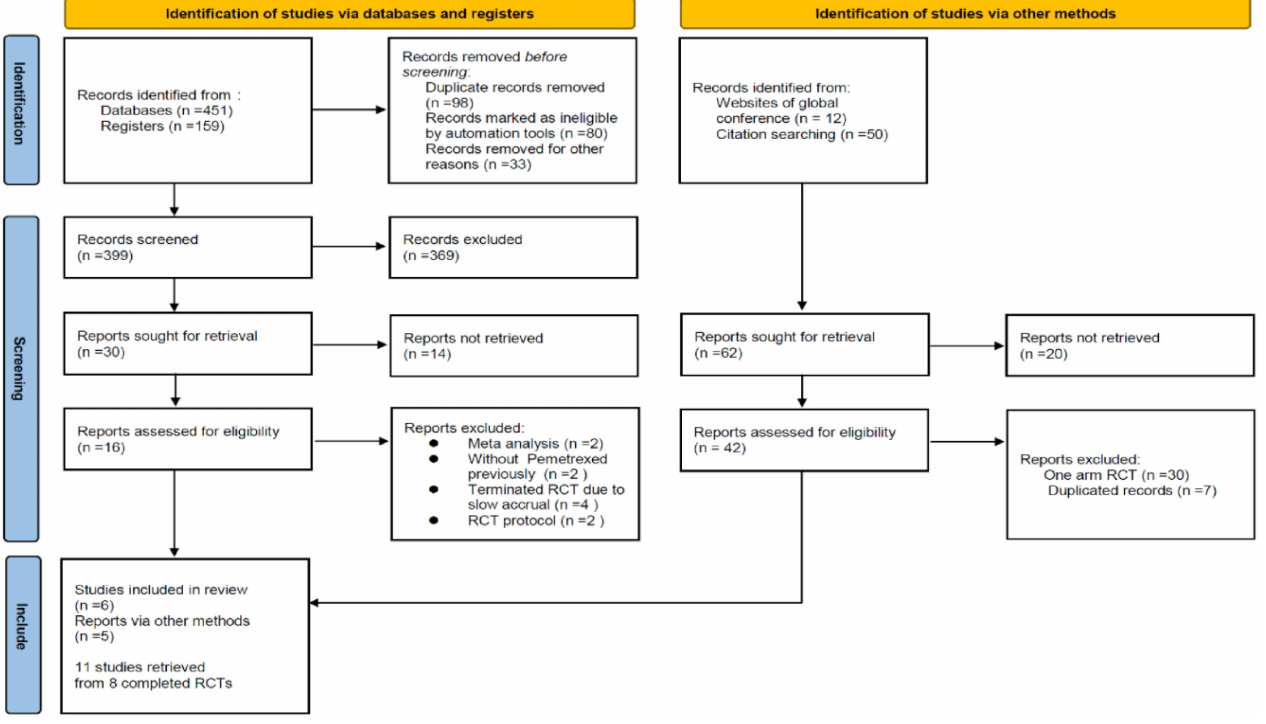
Figure 1. PRISMA flow